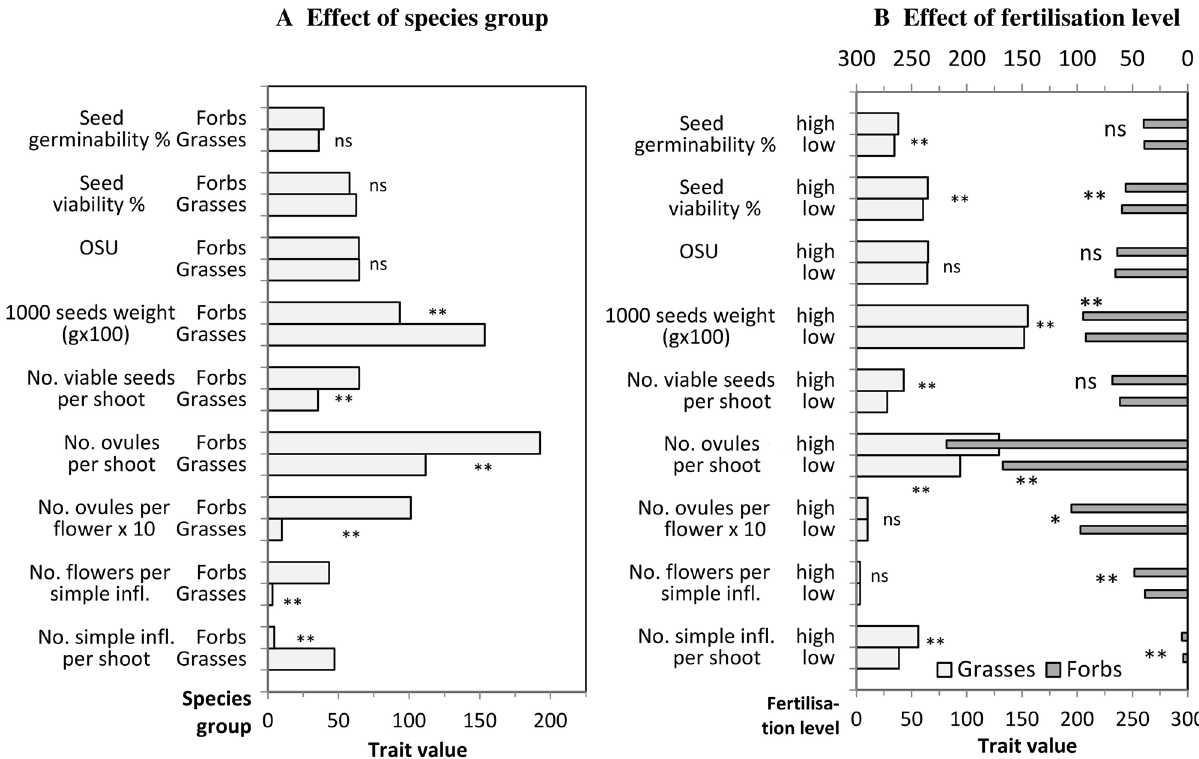
Figure 2. Mean values of the reproductive traits of fifteen grasses and seventeen forbs in a semi-natural grassland fertilisation trial. Graph A shows the comparison Grasse versus Forbs, graph B the comparison low vs. high fertilisation level within each functional group. ns, *, and **show the results of the Tukey’s test and mean not significant, significant at p ≤ 0.05, and significant at p ≤ 0.01, respectively. Individual species values are shown in Annex 3.